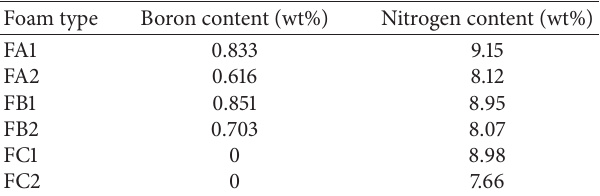
Table 10: Content of boron and nitrogen in the obtained foams.